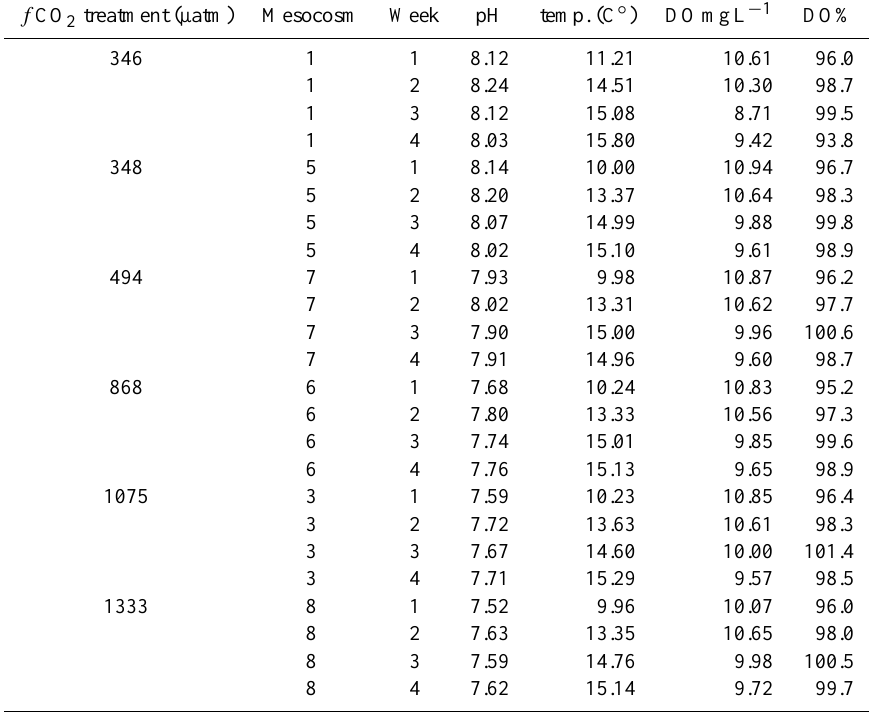
Table 1. f CO 2 values ( t 1 − t 30), average weekly pH, temperature, and dissolved oxygen (DO) and saturation in incubation bottles. f CO 2 treatment